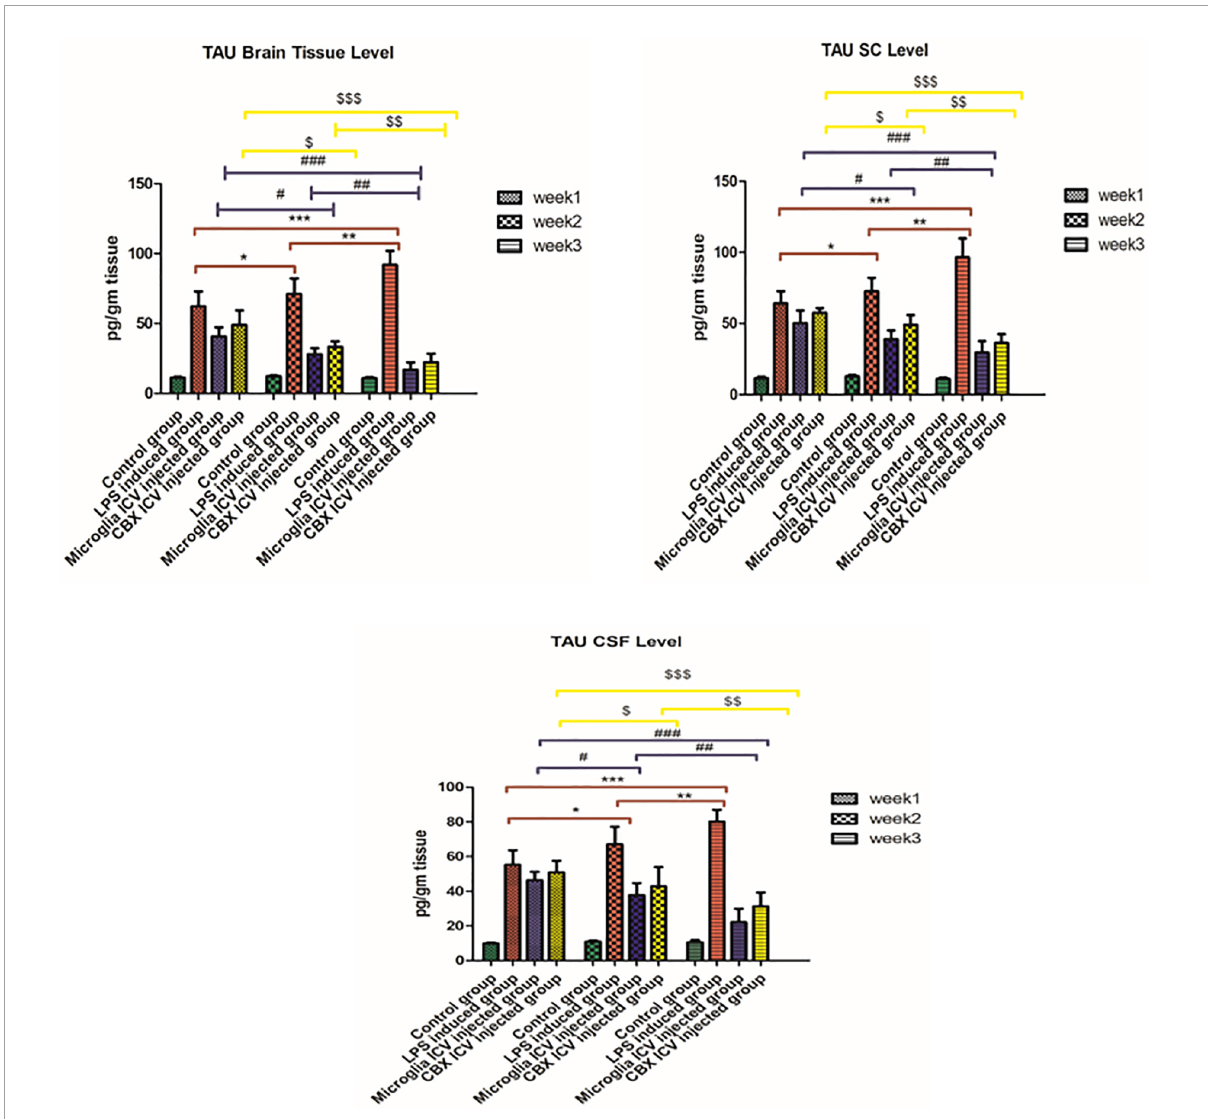
FIGURE5 Illustration of tau protein expression levels in brain tissue, spinal cord, and cerebrospinal fluid (CSF) in the lipopolysaccharide (LPS)-induced rats and following the single intracerebroventricular (ICV) administration of primary healthy microglia (PHM) and carbenoxolone (CBX) over the 3-week time interval. Represented data were expressed as mean ± SD ( n = 6 per group) (ANOVA, repeated measurement, Bonferroni post-hoc test, p < 0.05). The same asterisks represent an insignificant difference p >